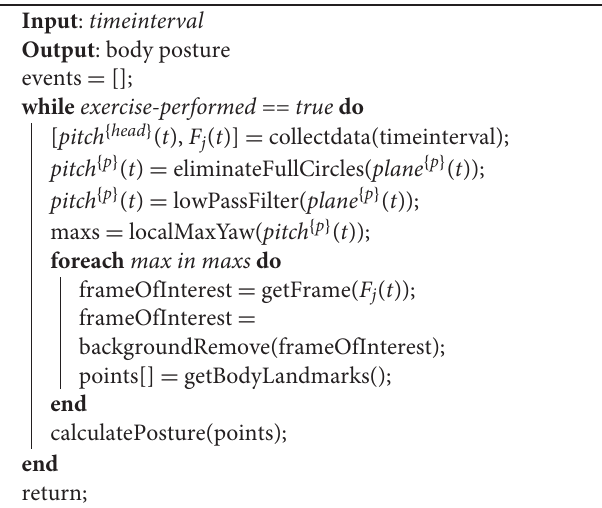
Algorithm 2: Posture estimation.